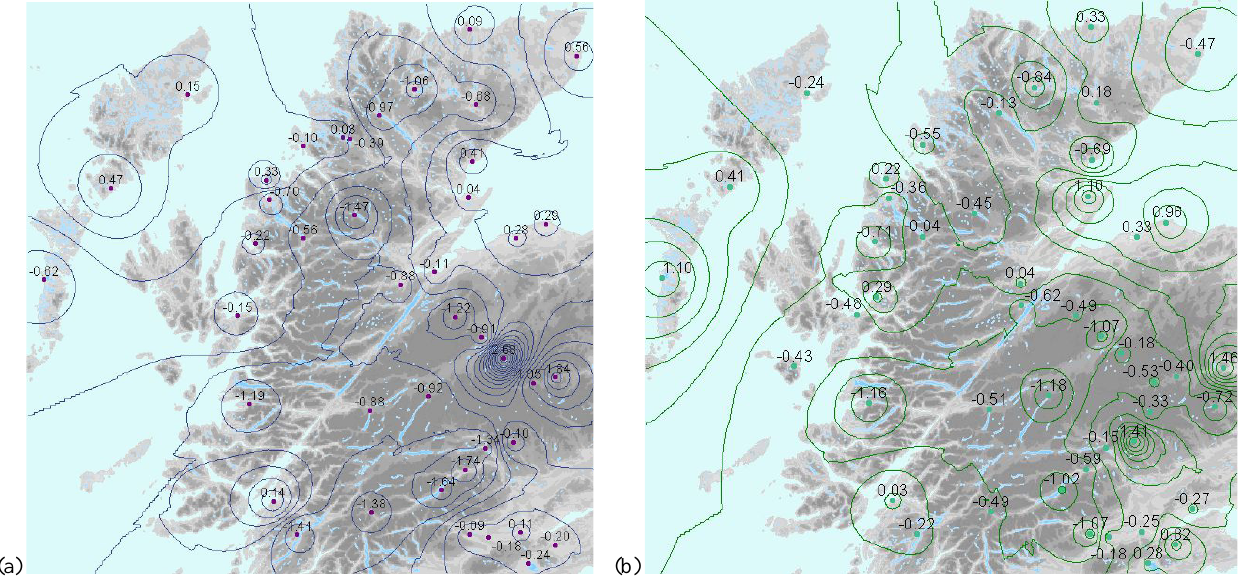
Figure 4. (a) Maximum Temperature station biases, October 2007. (b) Minimum Temperature station biases, January 2009. Values in ◦ C.